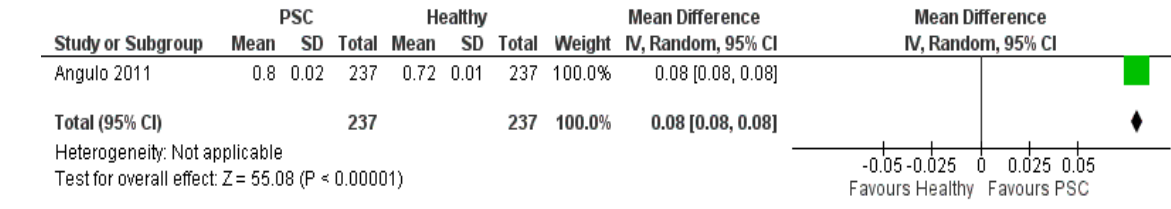
Figure 6. Forest plot assuming a random-effects model for BMD-hip PSC vs. Healthy [19].